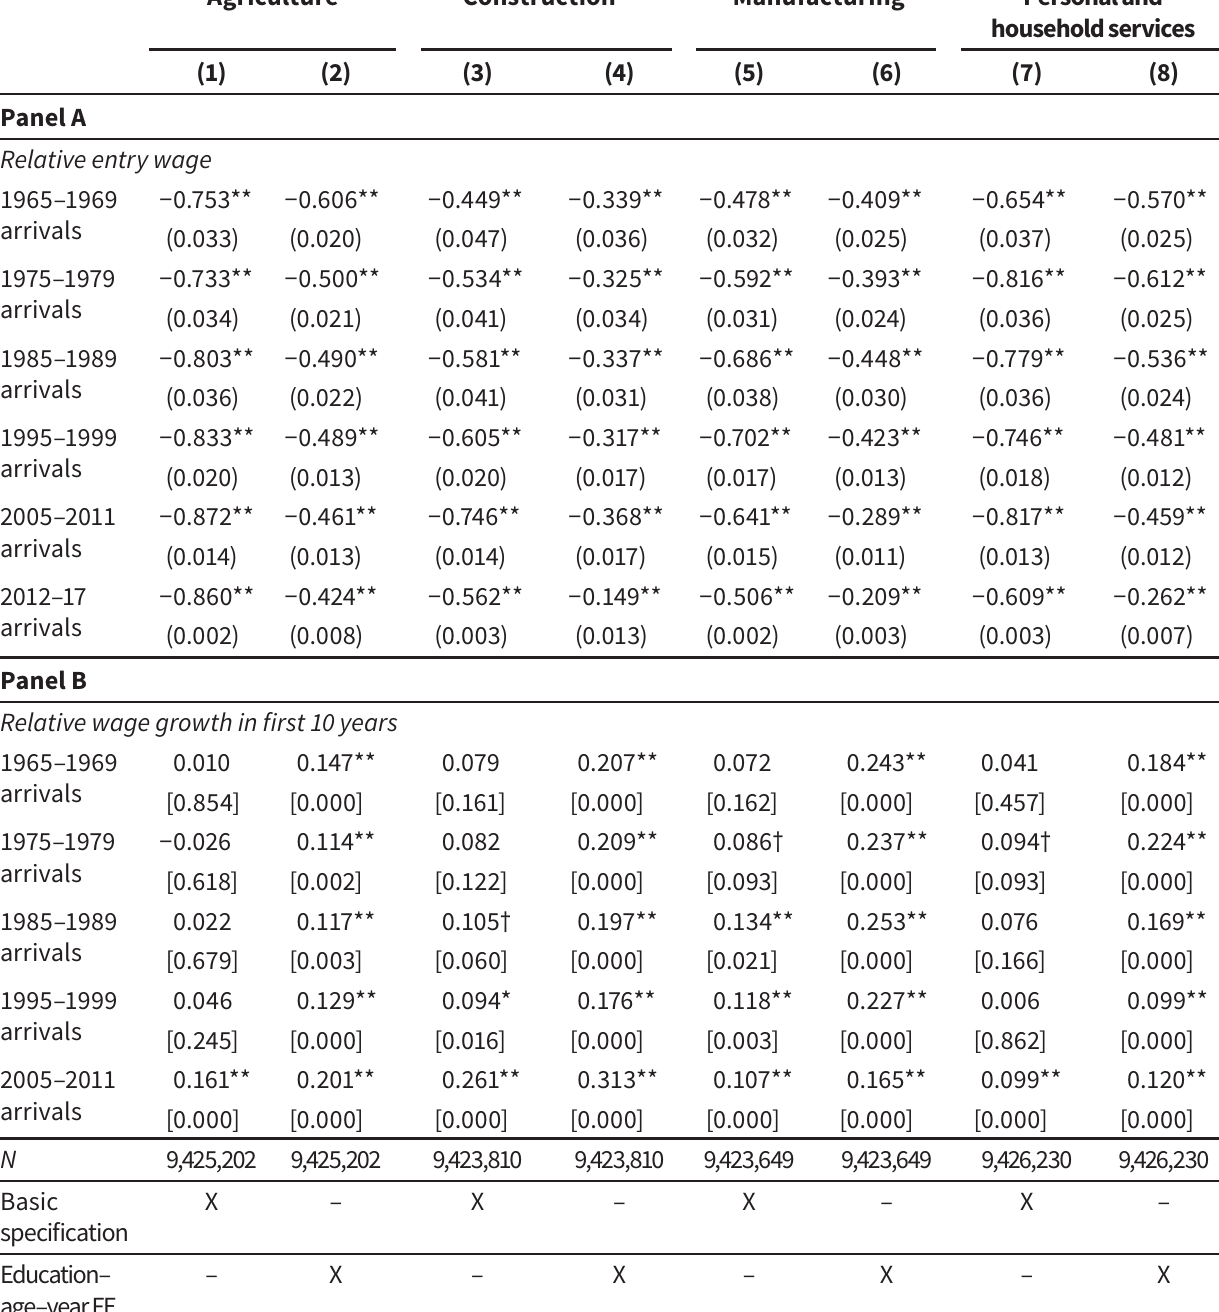
Mexican and Central American immigrants by sector: initial gaps and convergences after the first 10 years